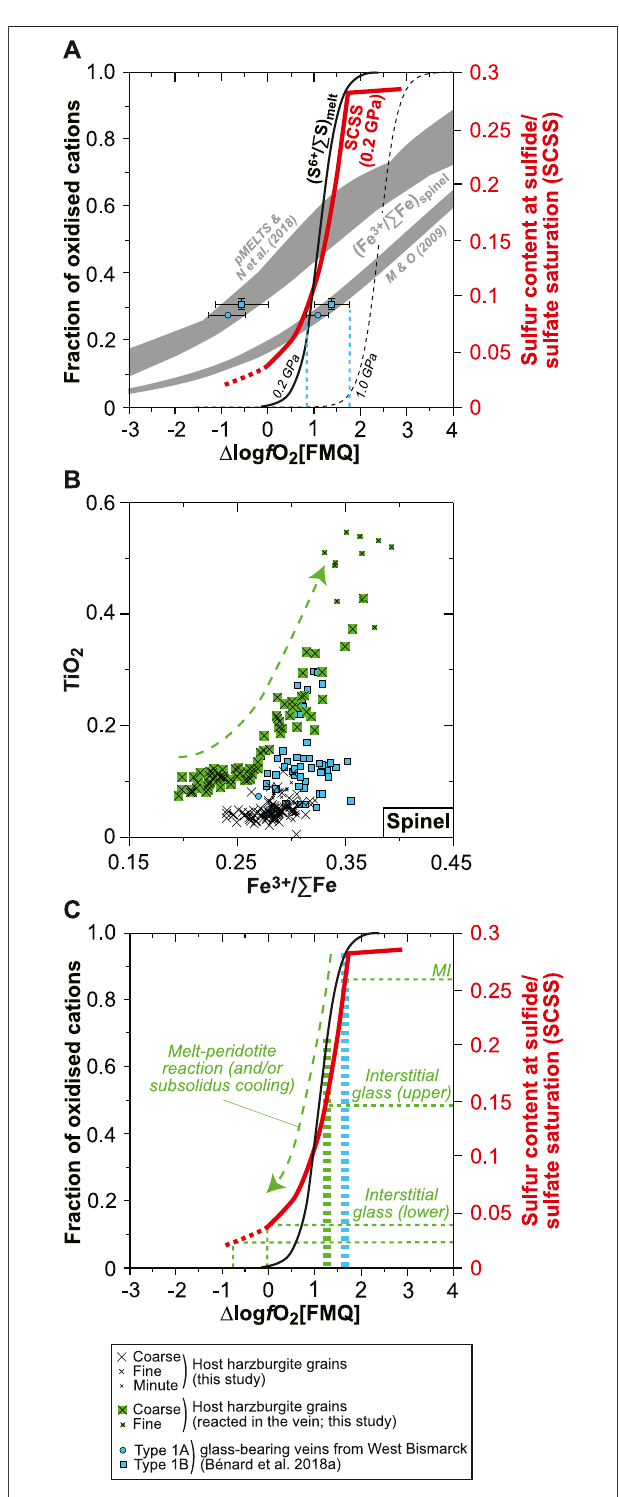
FIGURE 11 | Constraints on redox conditions and S 6+ – Fe 2+ redox exchange during melt-rock reaction for the new Kamchatka vein in this study. (A) Plot of SCSS and fractions of oxidized cations against Δ log f O 2 [FMQ] for S 6+ / (cid:1) Sinsilicatemelts(S 6+ / (cid:1) S melt ;blackcurves)andFe 3+ / (cid:1) Feinspinel (Fe 3+ / (cid:1) Fe spinel ; gray fi elds). The S 6+ / (cid:1) S melt curves are derived from